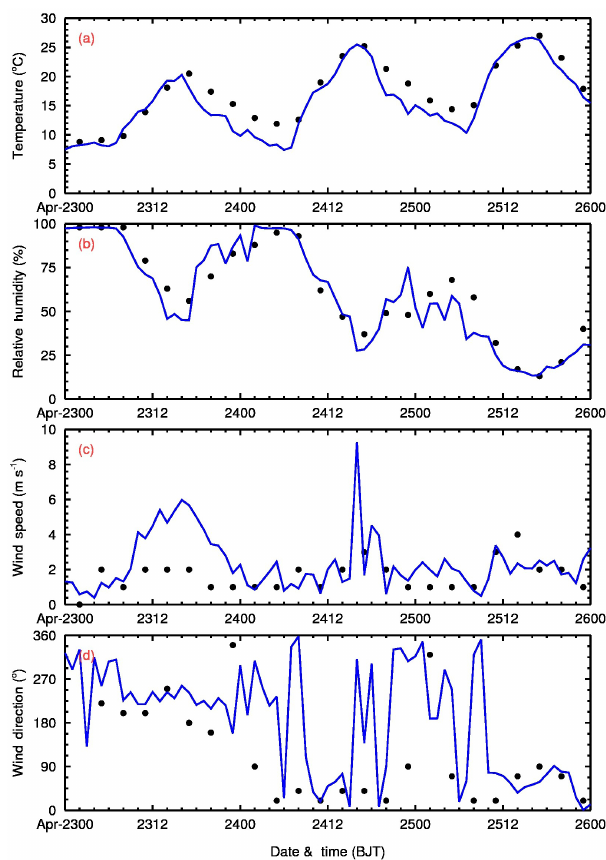
Figure 4. Temporal variations of simulated (blue line) and observed (black dots) meteorological fields including near-surface (a) tem- perature, (b) relative humidity, (c) wind speed, and (d) wind direc- tion at the Jinghe meteorological station which is close to Xi’an from 23 to 25 April